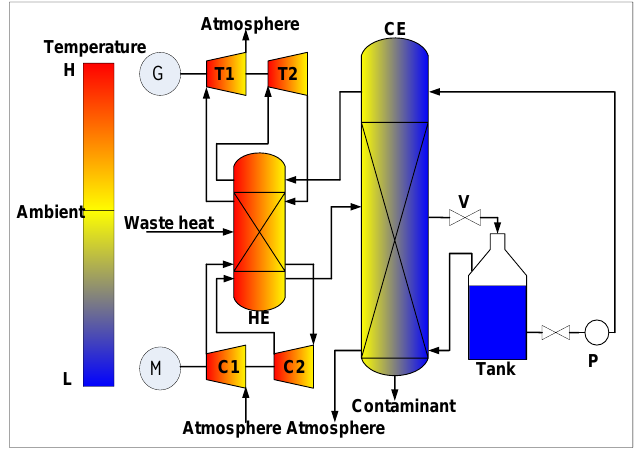
Figure 10. Schematic diagram of SC-CAES system (V—Throttle valve, C—Compressor, T—Turbine, G—Generator, M—Motor, P—Pump, HE—Heat storage & Exchanger, CE—Cold storage & Exchanger) [37].